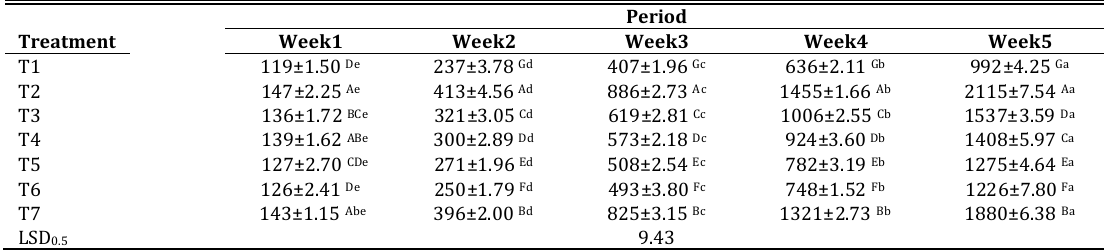
Table 2. Effect of different levels of Spirulina , probiotic, prebiotic, and antibiotic with or without E. faecalis infection on weekly live body weight (g) of broilers 1